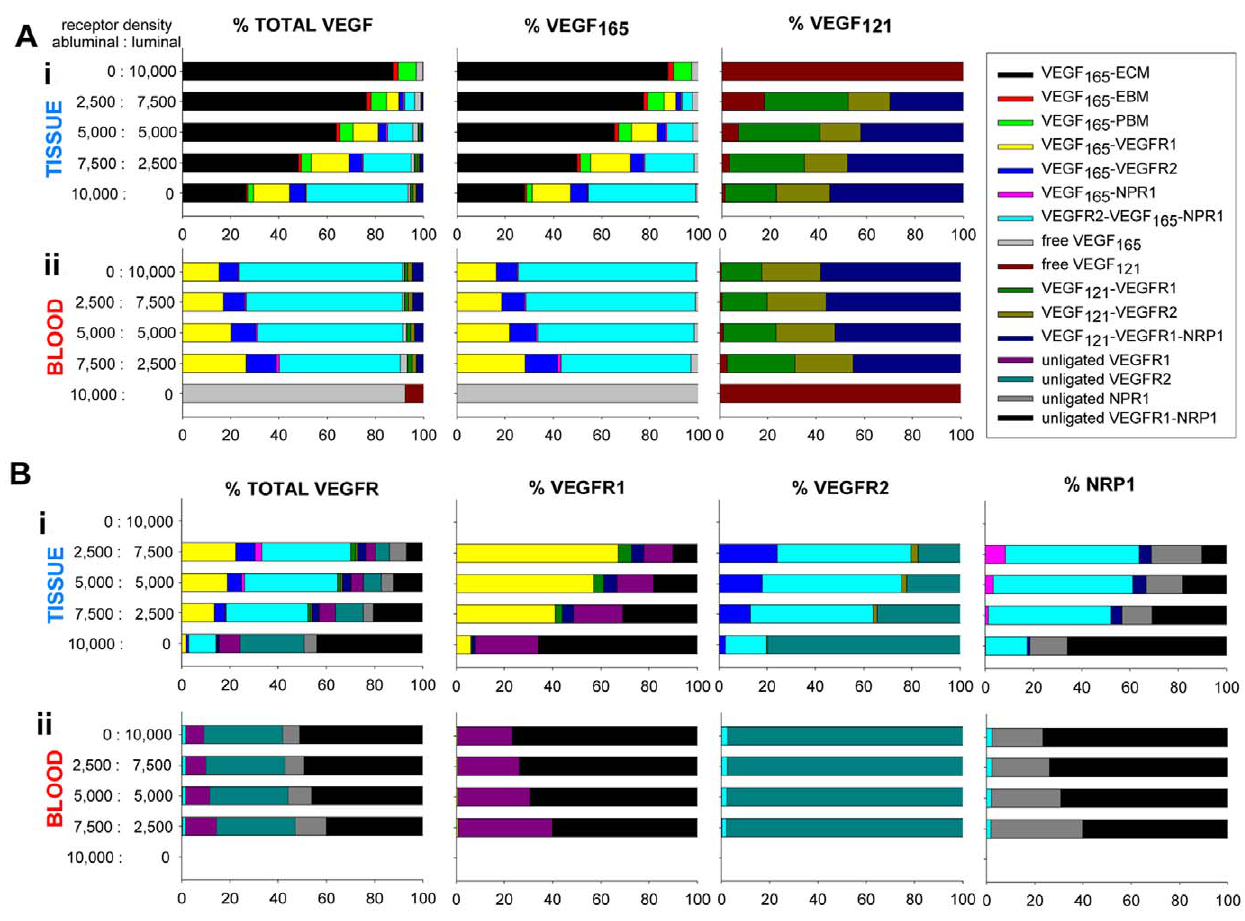
Figure 7. VEGF distribution and VEGFR occupancy for a total receptor density of 10,000 per endothelial cells. The scenarios correspond to those in Figure 6B. A. VEGF distribution. i. tissue; ii. blood. Columns from left to right: total VEGF distribution, VEGF 165 distribution, VEGF 121 distribution. In the absence of luminal receptors (bottom rows in i. and ii.), most VEGF bridges VEGFR2-NRP1 in the tissue and VEGF 165 :VEGF 121 in the plasma is 92%:8% similar to that of the isoforms expressions in the tissue. When abluminal receptor density decreases, VEGF is increasingly sequestered in the extracellular matrix (ECM, PBM, EBM) in the tissue compartment and VEGF 165 bridges VEGFR2-NRP1 in the plasma. B. VEGFR occupancy. i. tissue; ii. blood. Columns from left to right: total VEGFR occupancy, VEGFR1 occupancy, VEGFR2 occupancy, NRP1 occupancy. When the receptors are distributed on one side of the endothelial cells (either luminal or abluminal), most of the VEGF receptors are in the form of VEGFR1-NRP1 complex while most of VEGFR2 is in its free state (bottom row in i. and top row in ii.). When the receptors are distributed evenly between the endothelial cells luminal and abluminal surfaces, the luminal receptor occupancy remains unchanged (top and middle rows in ii.) but the VEGF receptor occupancy in the tissue shifts towards VEGF 165 bridging VEGFR2-NRP1 (bottom and middle rows in i.). surface of the endothelial cells. The ratio [VEGF bound to purple (scenario (b)) and green (scenario (c)) dots correspond to the abluminal VEGFR1]/[VEGF bound to luminal VEGFR1] is cases studied in Figure 6A. We found that only a small fraction of shown in Figure 9A and the ratio [VEGF bound to abluminal VEGF is free in the available interstitial fluid. Most VEGF is either VEGFR2]/[VEGF bound to luminal VEGFR2] is illustrated in bound to the abluminal receptors or sequestered in the matrix. Figure 9B. For most cases, these two ratios were higher than 1, VEGF is more and more bound to the receptors and less and less meaning that the amount of VEGF bound to VEGFR1 or sequestered in the matrix when the density of luminal receptors VEGFR2 was higher on the abluminal than on the luminal decreases and the density of abluminal receptors increases. In the surface of the endothelial cells. This is explained by the fact that the blood, VEGF becomes more bound to the receptors with the VEGF secretion occurs in the tissue, leading to a VEGF gradient increasing density of luminal receptors but the general VEGF from the tissue to the blood compartment. However, a small region distribution in this compartment does not significantly vary with revealed more binding on the luminal side (ratio , 1) for VEGFR2 the abluminal receptor density across the interval tested. (Figure 9B). This small region corresponds to low abluminal and Because the VEGF secretion occurs in the tissue, VEGF high luminal receptor densities. This region reveals receptor binding binding to VEGFR1 and VEGFR2 takes place predominantly for VEGFR1 higher on the abluminal endothelial surface on the abluminal surface of the endothelial cells, regardless (Figure 9A). Therefore, at low abluminal and high luminal of the ratio of the receptors on each surface of endothelial receptor densities, there is more binding to VEGFR1 on the cell. We next looked at how much VEGF is bound to the receptors on the abluminal surface of the endothelial cells as abluminal surface and more binding to VEGFR2 on the luminal compared to how much VEGF is bound to receptors on the luminal surface. This particular region calls for experimental exploration.